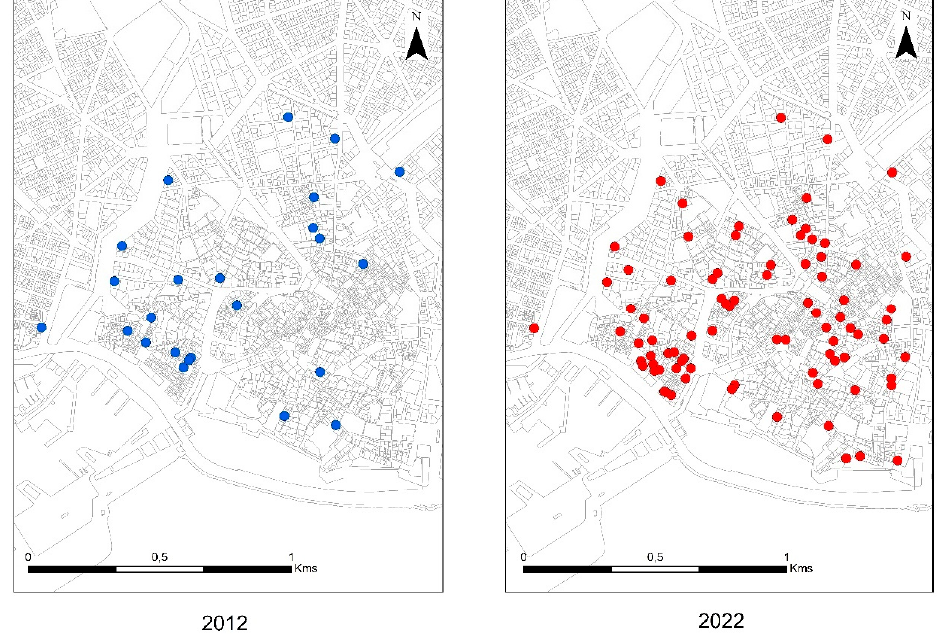
Figure 3. Location of hotel establishments in the historic centre of Palma. Source: Authors and the Register of Tourism Establishments of the Consell Insular de Mallorca.